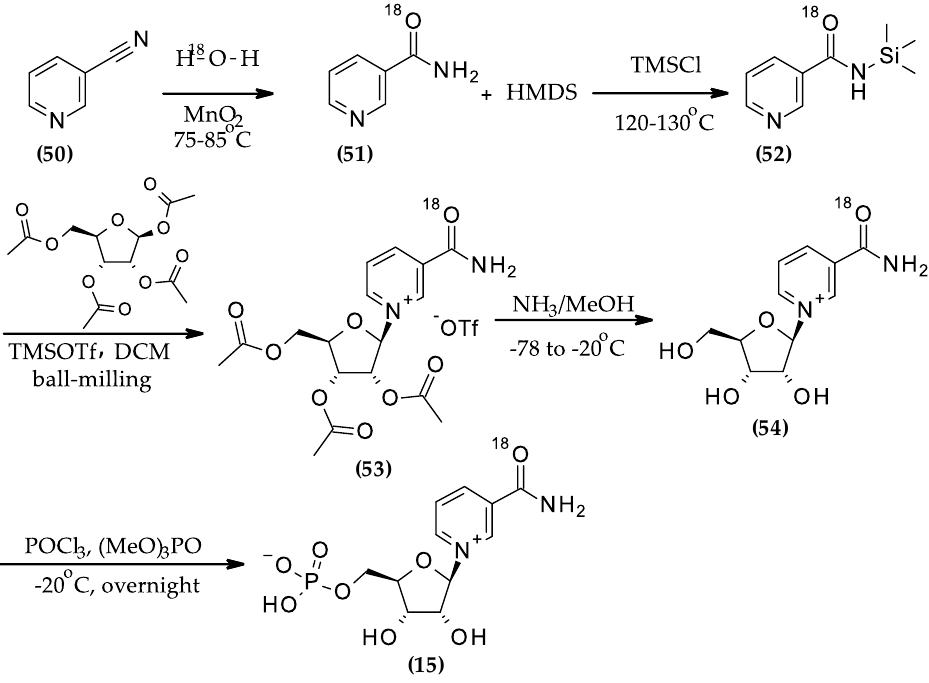
Scheme 7. Preparation of 18 O MW+2 nicotinamide